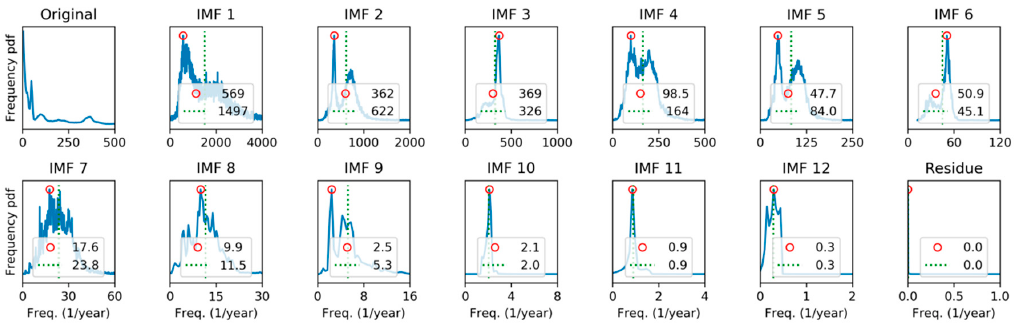
Figure 18. Instantaneous frequency Probability Density Function (PDF) of the electricity demand IMFs. Instantaneous frequency mode (red circle) and mean (dashed green line) are marked.